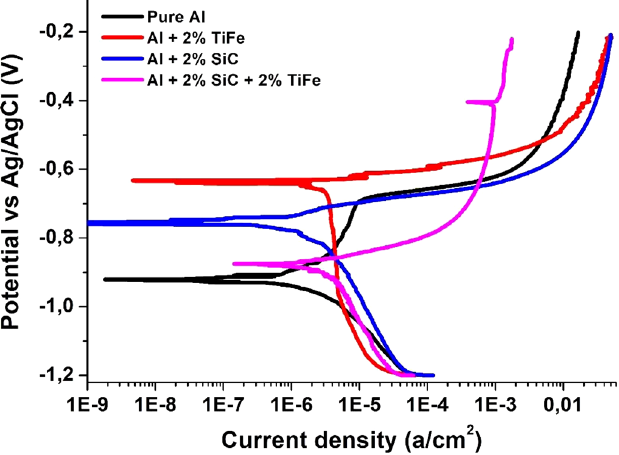
Fig. 2. Potentiodynamic polarization curves for sintered pure aluminium and